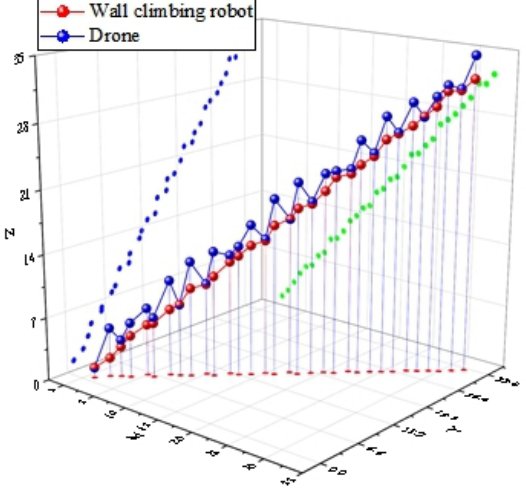
Fig. 3. Planning renderings of wall-climbing robots and